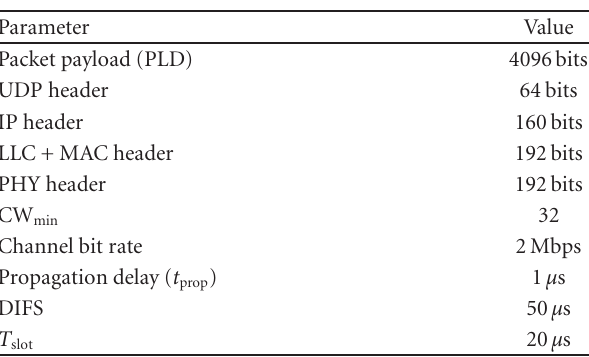
Table 1: Selected input parameter values